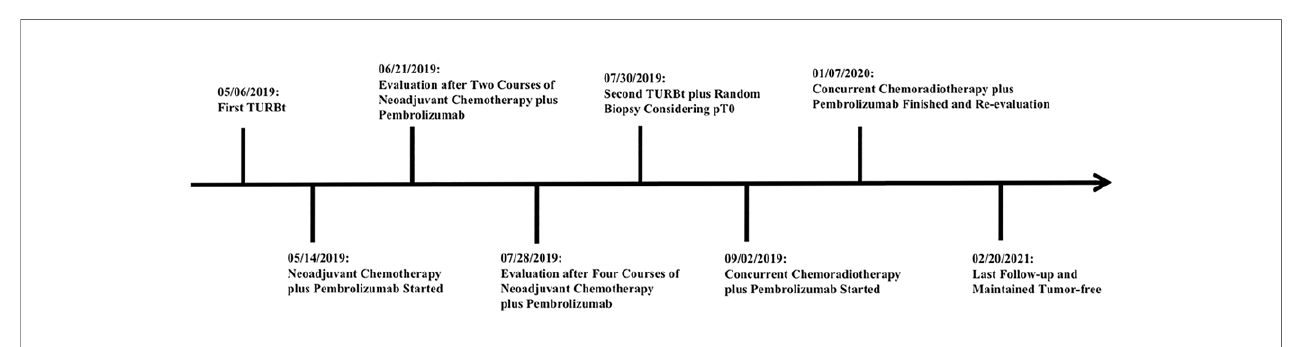
FIGURE 3 | Timeline of patient treatment.